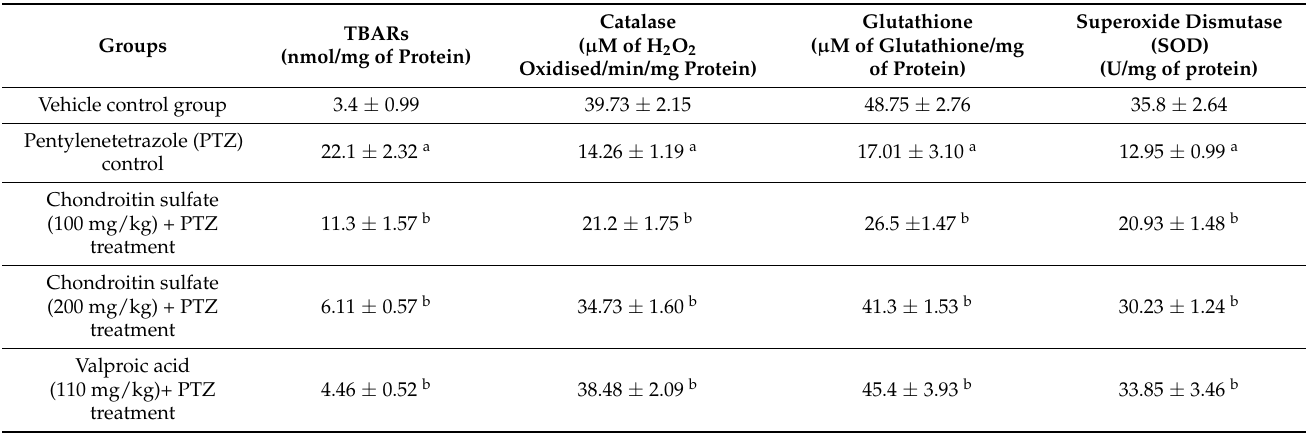
Table 1. Antiepileptic effect of CS on biochemical estimation parameters in PTZ-induced kindling seizures. Values are expressed as mean ± S.D.; a p < 0.01 vs. vehicle control; b p < 0.05 vs. PTZ control.